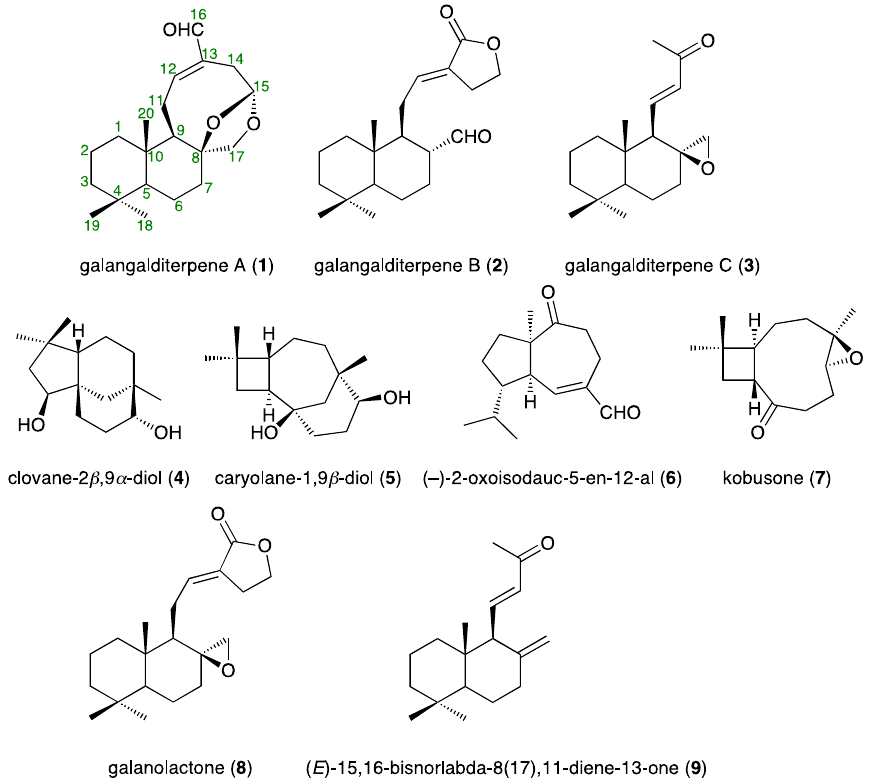
Figure 1. Structures of isolates ( 1 – 9 ) from the fruit of A. galanga .